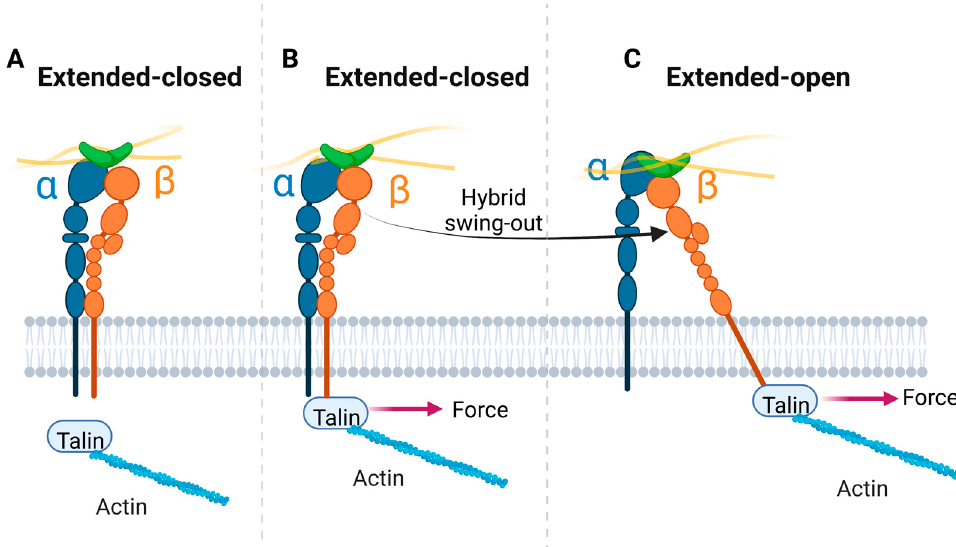
Figure 5. Effect of talin binding and pulling on integrin conformation. ( A ). Schematics of ECM-bound integrin in extended-closed conformation. ( B ). Once the extended-closed conformation of integrin attaches to intracellular talin, a membrane-parallel force is exerted on the β tail. ( C ). The connection of talin to the actin cytoskeleton provides lateral pulling of the β tail, which reorients the transmembrane β helix relative to the α helix, to induce the extended-open conformation. A single integrin is shown here; note, however, that integrins usually function in clusters.